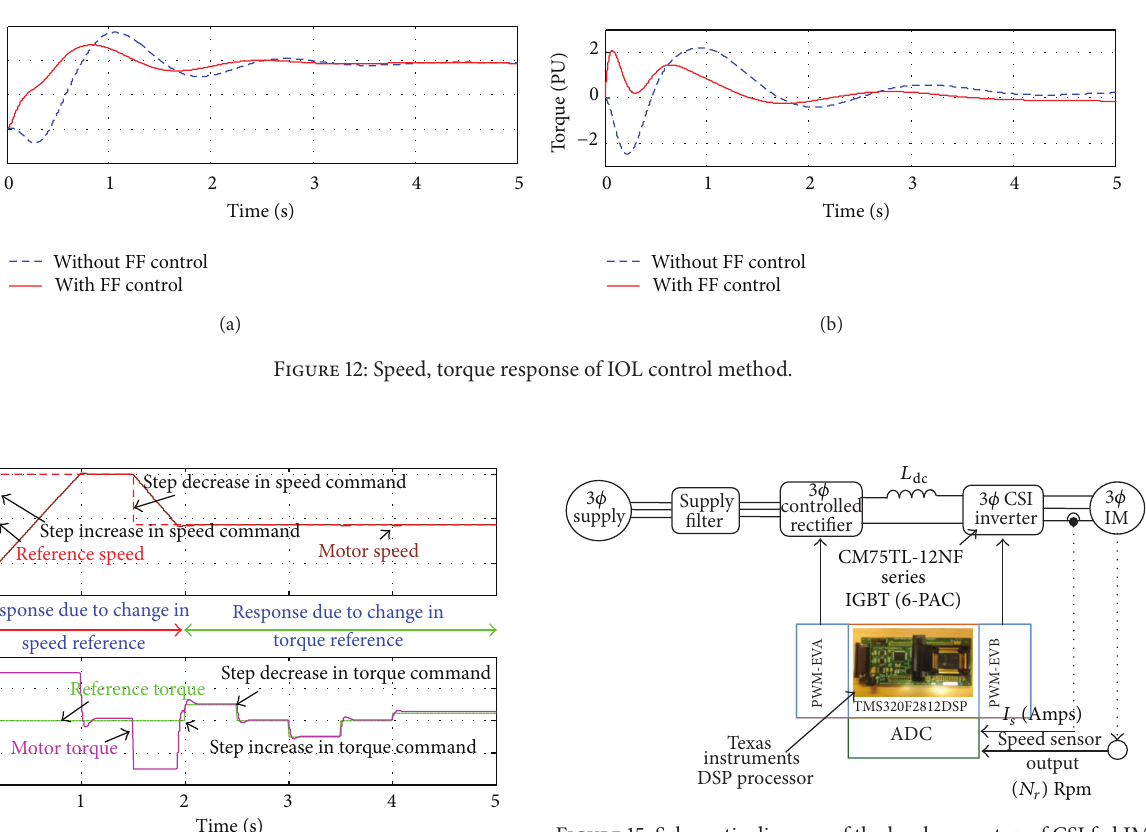
Figure 15: Schematic diagram of the hardware setup of CSI fed IM.